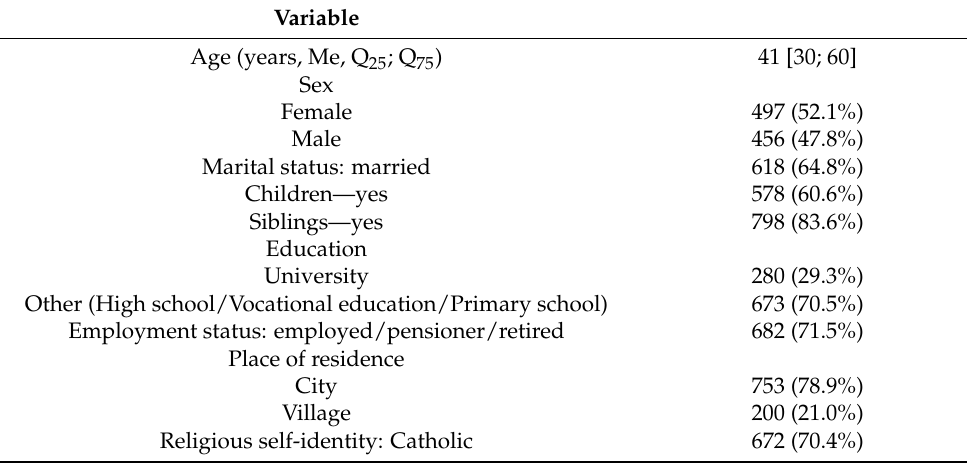
Table 1. Sociodemographic factors ( n =